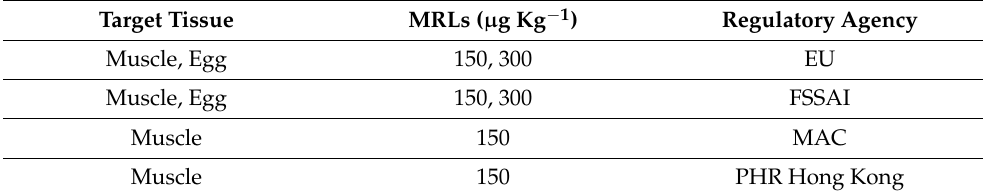
Table 1. Maximum residue limits (MRLs) of colistin recommended by different regulatory agencies, adapted from Kumar et al. [1]. Target Tissue MRLs ( µ g Kg − 1 ) Regulatory Agency Muscle, Egg 150, 300 EU Muscle, Egg 150, 300 FSSAI Muscle 150 MAC Muscle